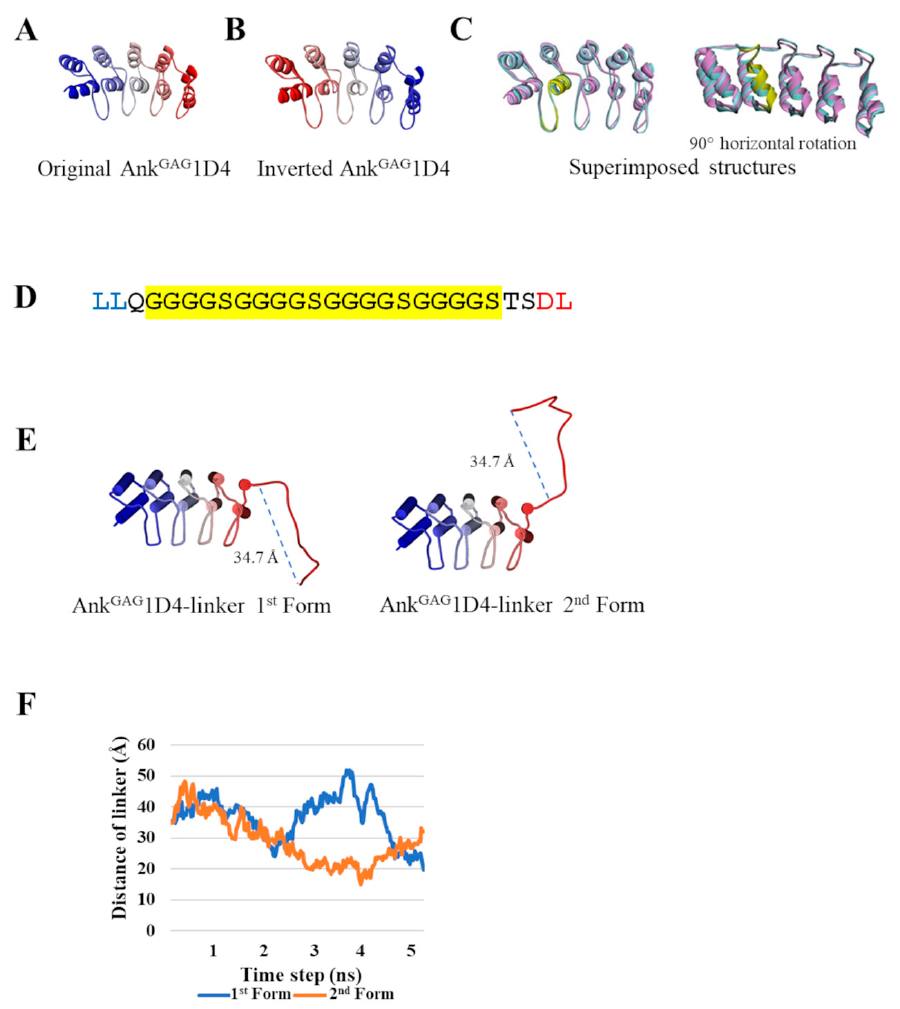
Figure 1. Initial structure of ankyrin before creating Ank GAG 1D4 dimers: ( A ) The structure of the original Ank GAG 1D4; ( B ) Inverted Ank GAG 1D4, which is presented in ribbon style from blue at the N-terminus to red at the C-terminus; ( C ) The superimposed structure between the original Ank GAG 1D4 (pink) and inverted Ank GAG 1D4 (sky) with the yellow showing binding region, 44 DSIGSTPLHLAAYYG 58; ( D ) The amino sequence of the flexible linker consists of (G 4 S) 4 linker and extra residues. Blue and red are used for superimposition with the first and second ankyrin modules, respectively; ( E ) Two versions of Ank GAG 1D4-linker were obtained from superimposition between Ank GAG 1D4 and a linker. They are initial structures for molecular dynamics simulation. The blue dash line shows how linker distance is measured; ( F ) Distance of the linker is part of the simulated dynamics of the Ank GAG 1D4-linker during 5 ns.